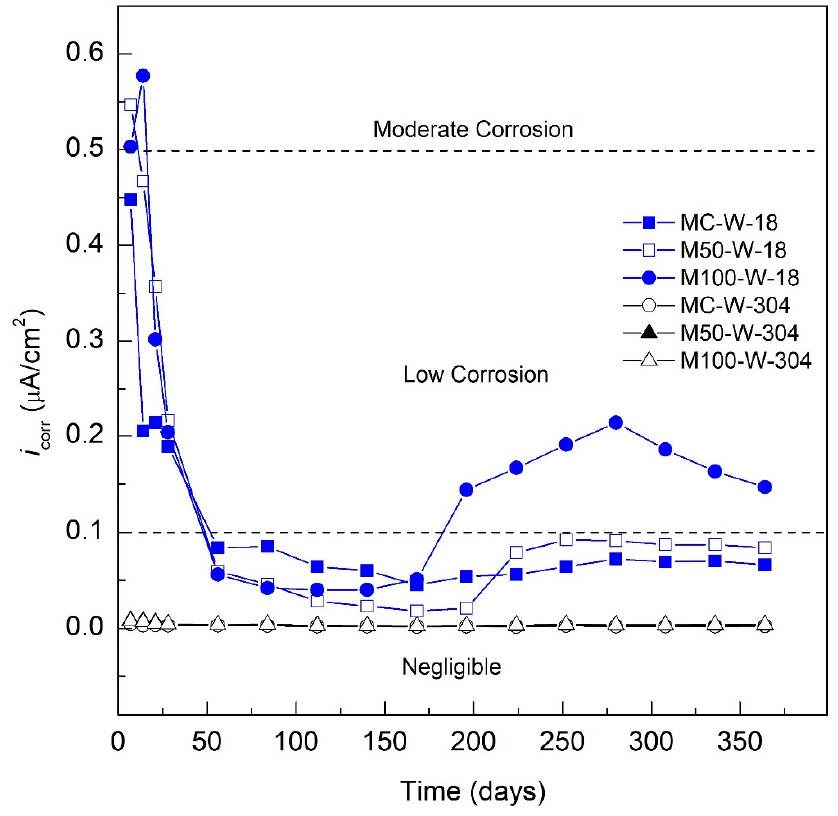
Figure 6. i corr specimens exposed DI-water (control medium).